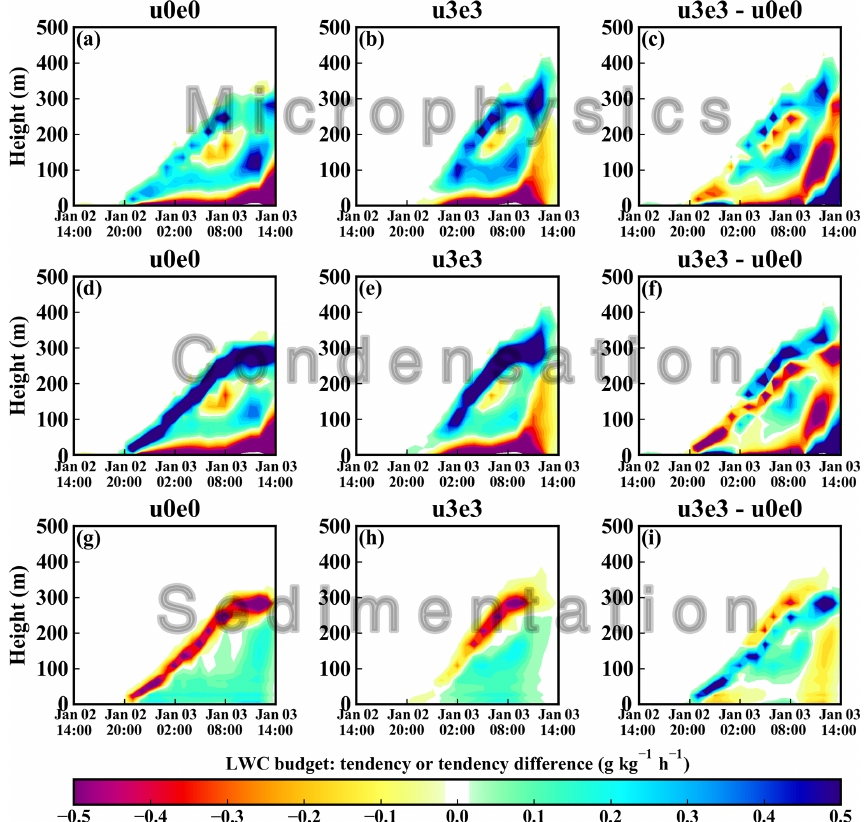
Figure 11. The combined effect of urbanization and aerosols (u3e3 minus u0e0) on various items of the microphysical tendency. The three rows are the tendencies (gkg − 1 h − 1 ) of the microphysical, condensation–evaporation and sedimentation